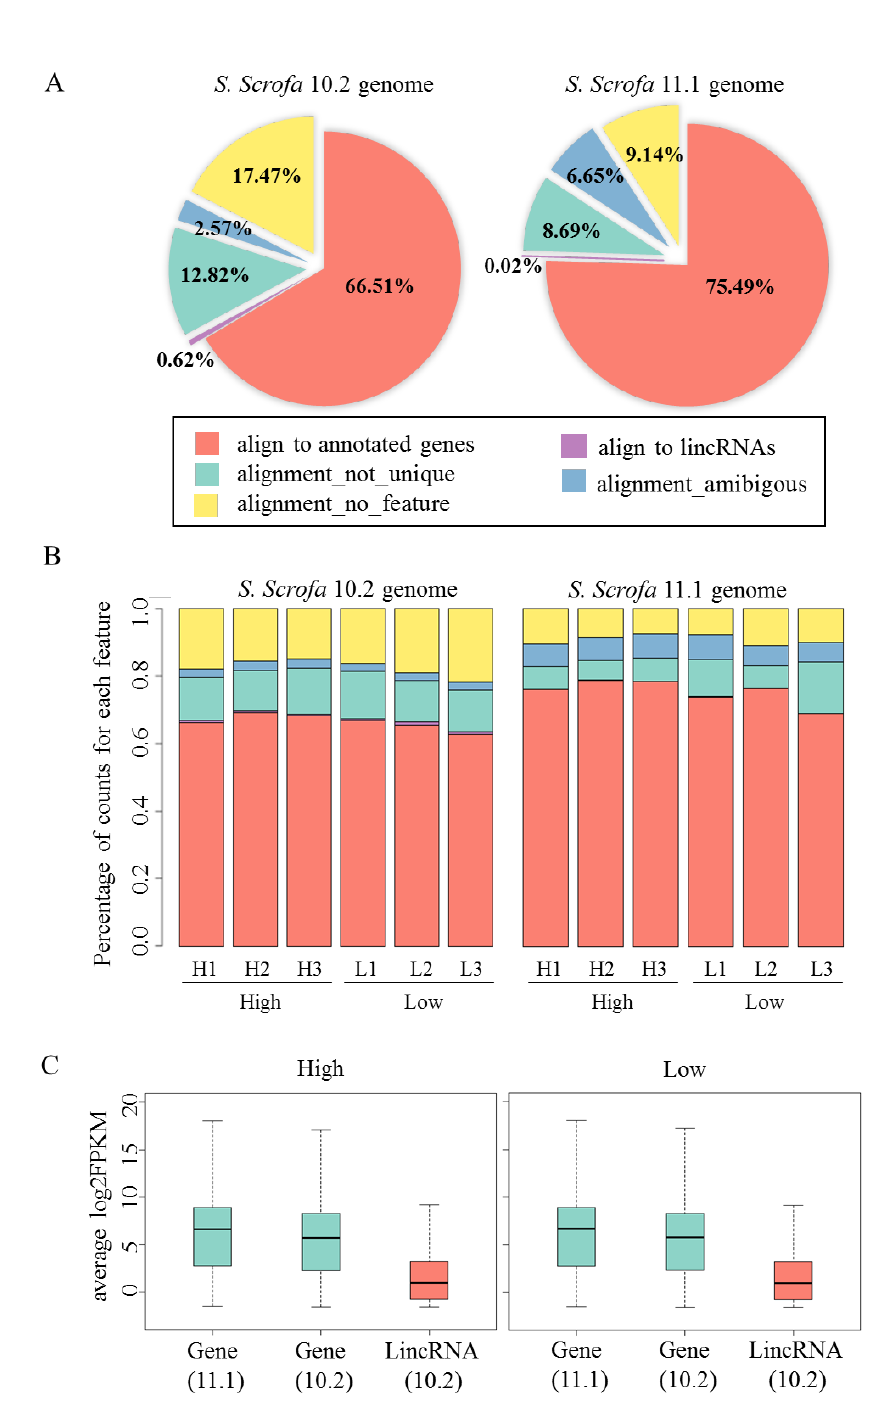
Figure 1. Annotation and alignment of RNA-seq read pairs from porcine adipose tissue with different genome version. ( A ) Distribution of average mapped read pairs of six samples on the S scrofa 10.2 ( left ) and S. scrofa 11.1 ( right ) genomes. In the pie charts, the percentages represent the mean of all six RNA-seq data. On average, over 66% unique read pairs were aligned to annotated genes. ( B ) Distribution of mapped read pairs in different samples. Samples that belong to the same genome group show similar distribution. The color of bar standing for the same meaning as pie charts. ( C ) Boxplots showing the expression patterns (scaled log2FPKM) of annotated genes and long intergenic non-coding RNAs (lincRNAs) in high Feed Efficiency (high-FE) ( left ) and low-FE ( right ) groups, respectively.